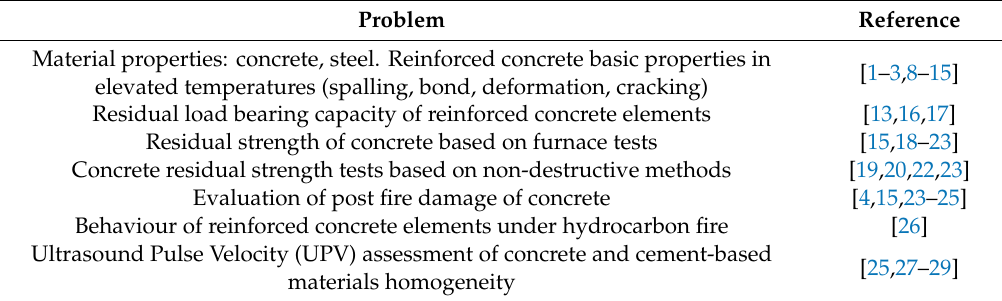
Table 1. References and problems related to the paper